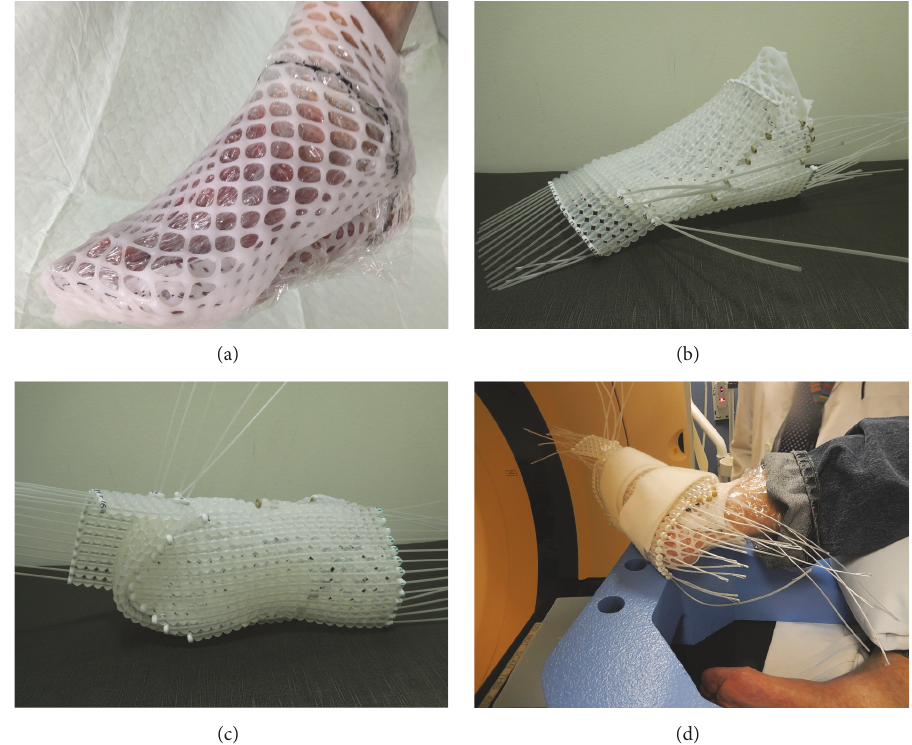
Figure 2: (a)Two-part thermoplastic mesh encompassing the left foot with proximal borderof treatmentarea outlined in black. (b)Complete Freiburg device consisting of a total of 39 catheters. (c) Plantar aspect of the Freiburg device. (d) Positioning of the left foot for CT scan and treatment.